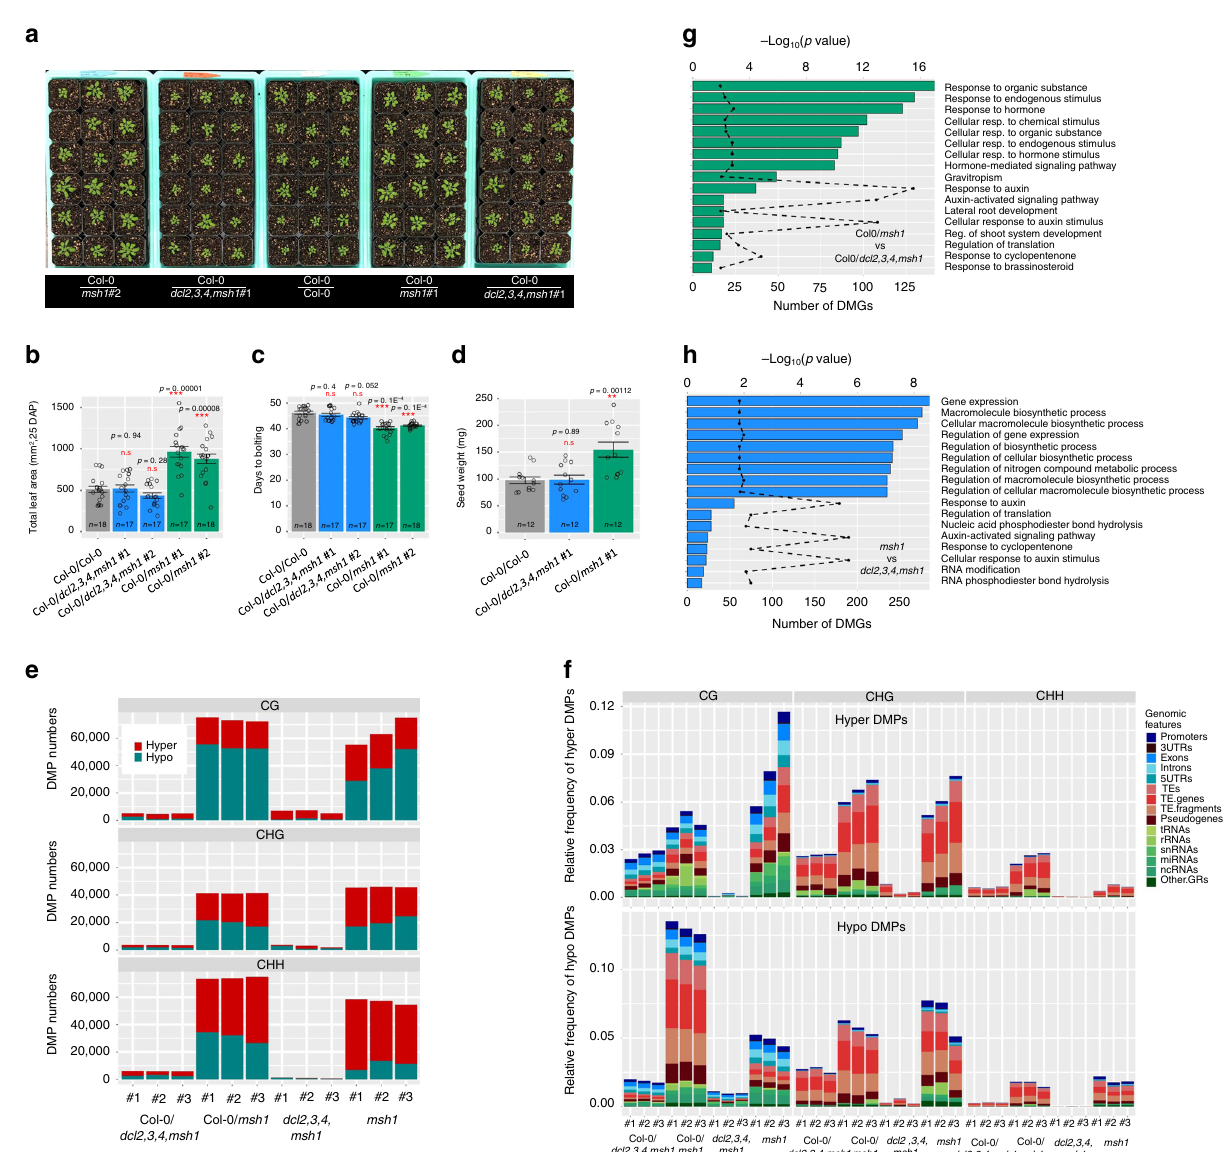
Fig. 4 In fl uence of siRNA on the graft progeny phenotype and methylation repatterning. a The phenotype of graft progeny ( fi rst generation) from Col-0/ Col-0, as graft control, Col-0/ msh1 , with msh1 rootstock, and Col-0/ dcl2,3,4,msh1 , with a dcl2,3,4, msh1 quadruple mutant as rootstock. Seedling stage photo was taken at 21 days after planting (DAP). b Total leaf area (25 DAP), c days to bolting, and d seed weight (mg) for the fi rst-generation graft progeny of Col-0/Col-0, Col-0/ msh1 and Col-0/ dcl2,3,4 . b – d Bars represent means ± SE, n represents number of plants in each population. The Mann – Whitney U -test with two-sided alternative hypothesis were used to test the signi fi cance of the difference of mean in each comparison. e Total hyper- and hypomethylation DMP counts of fi rst-generation graft progeny in Col-0/ dcl2,3,4,msh1 vs. Col-0/ msh1 comparison and in rootstocks of dcl2,3,4,msh1 vs. msh1 comparison. Each bar graph represents a single plant. CG, CHG, CHH context data are shown separately for each plant. DMPs were de fi ned as hyper if the site methylation difference in comparisons of each individual to the average of reference plants is greater than 0 and de fi ned as hypo if <0. f The relative frequency of DMPs over genic regions (blue shades), TE-related regions (red shades), and others (green shades) in fi rst-generation graft progeny in the Col-0/ dcl2,3,4,msh1 vs. Col-0/ msh1 comparison and rootstocks in the dcl2,3,4,msh1 vs. msh1 comparison. The centroid of Col-0/ dcl2,3,4,msh1 graft progeny was used as a reference for Col-0/ msh1 analysis and dcl2,3,4,msh1 was used as reference for msh1 mutant analysis. Networks identi fi ed by Network Enrichment Analysis Test (NEAT) for the DMGs identi fi ed are shown for g Col-0/ dcl2,3,4,msh1 vs. Col-0/ msh1 and h dcl2,3,4 msh1 vs. msh1 comparisons. g , h p -values were computed using one-sided hypergeometric distribution test as implemented in NEAT (R package version 1.1.3). Signi fi cance codes: NS, no signi fi cance, * p < 0.05, ** p < 0.01, *** p < 0.001. Source data underlying b – h are provided as a Source Data fi